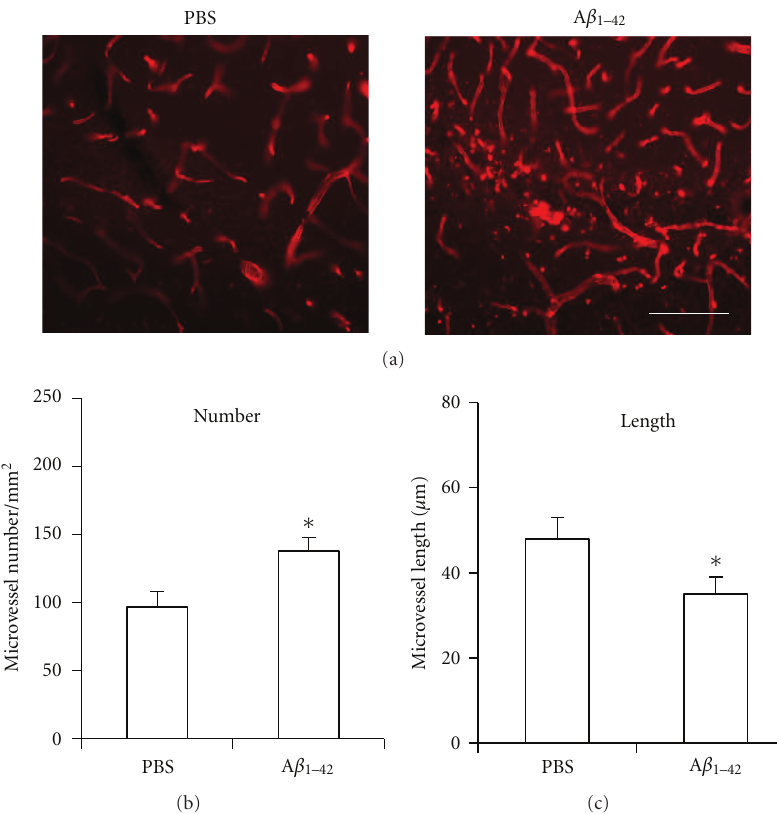
Figure 1: Representative patterns of RECA-1 staining in rat hippocampus. (a) Microvessels in control (PBS) injected rat hippocampus (left panel) and microvessels in A β 1 − 42 -injected hippocampus (right panel). Scale bar is for 70 μ m. (b) Bar graph for the number of microvessels/mm 2 ( n = 5 each). (c) Bar graph for microvessel length ( n = 5 each). ∗ P ≤ 0 . 05 for A β 1 − 42 versus